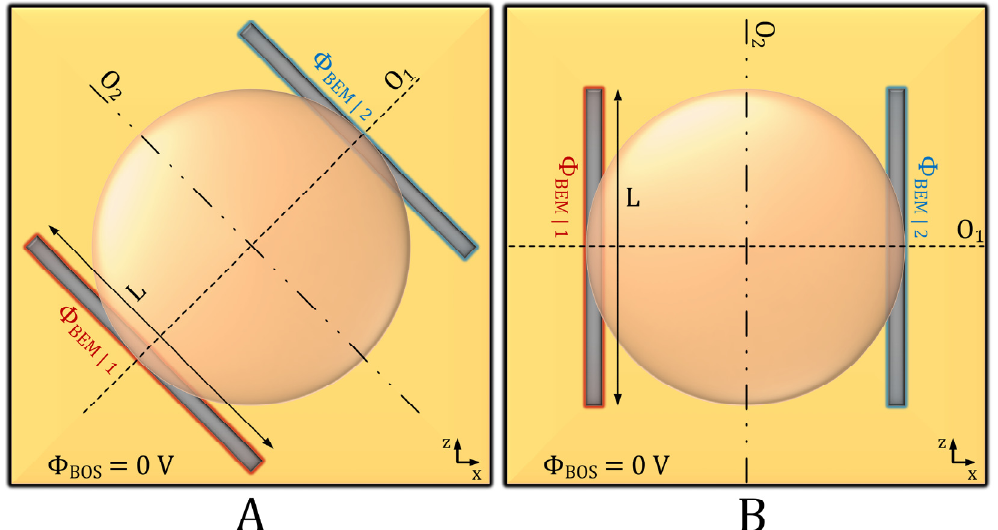
Figure 5. A spherical pancreatic tumor with a pair of cylindrical electrodes at its extreme ends inside a cube of healthy pancreatic tissue. In ( A ) the cancer model was rotated around the y-axis by 45° in the x,z-plane, while in ( B ) the electrodes were positioned parallel to the z-axis. Electric-field distri- butions from ( A ) and ( B ) were compared along the lines O 1 and O 2 in the x,z-plane.